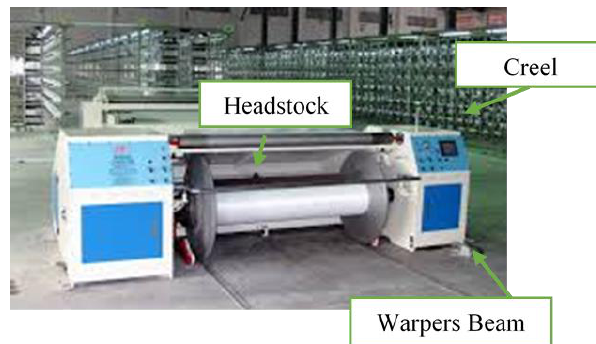
Figure 2. Warping machine structure.